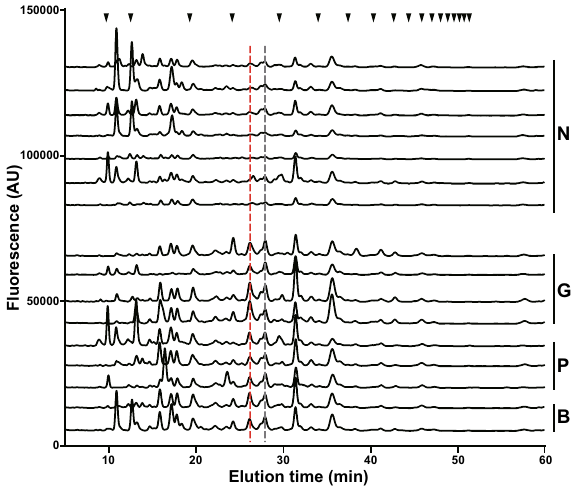
Figure 1. Reversed phase-HPLC chromatograms of PA-labeled neutral free-glycans prepared from the urine of normal individuals and cancer patients. PA-labeled neutral free-glycans fractionated by NP-HPLC were further separated by RP-HPLC. Chromatograms corresponding to RP-HPLC of NP-fraction 8 eluted by NP-HPLC are shown. These chromatograms contain neutral free-glycans in urine equivalent to 50 μg of creatinine. Representative chromatograms of seven normal individuals (N6, N7, N11, N14, N15, N19, N21), four gastric cancer patients (G2, G5, G8, G10), three pancreatic cancer patients (P2, P3, P5) and two bile duct cancer patients (B2, B4) are shown. The red dotted line indicates the peak containing the pentose-attached glycan, which was increased in cancer patients. The gray dotted line peak contains the xylose- and fucose-attached glycans measured by SRM (see Fig. 6). The black inverted triangles represent glucose units based on the elution time of PA-labeled